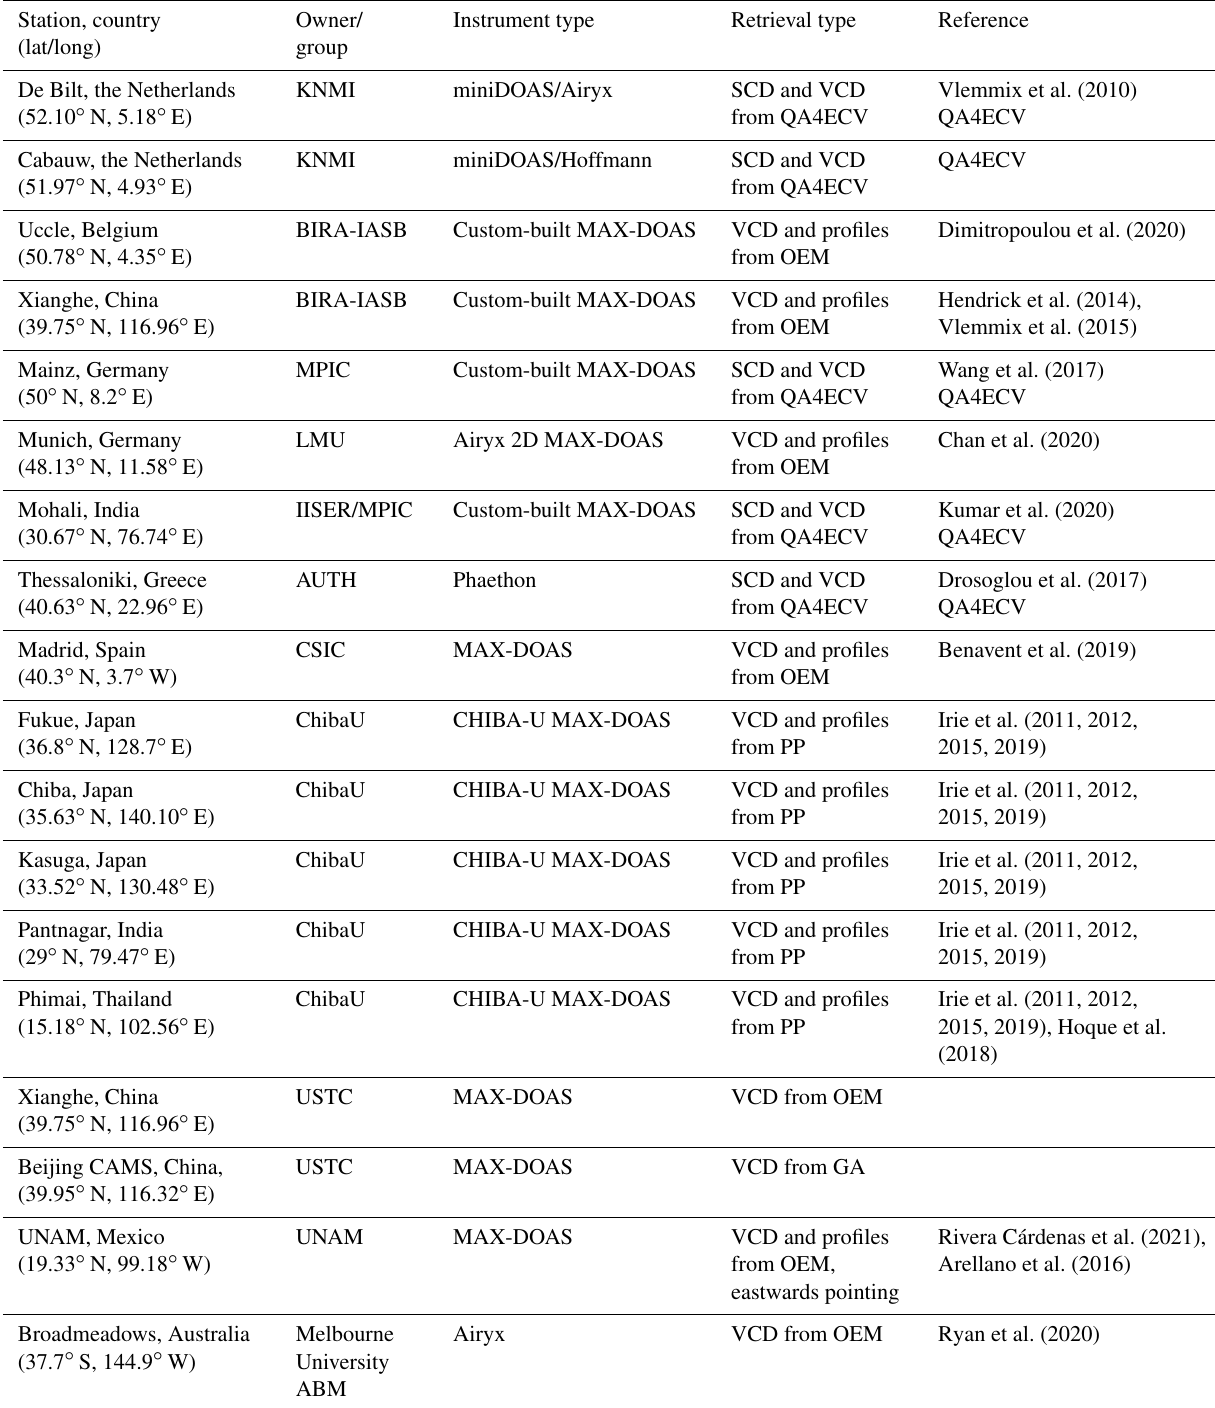
Table 1. MAX-DOAS HCHO datasets included in the validation exercise. GA stands for geometrical approximation, OEM for optimal estimation method and PP for parameterized